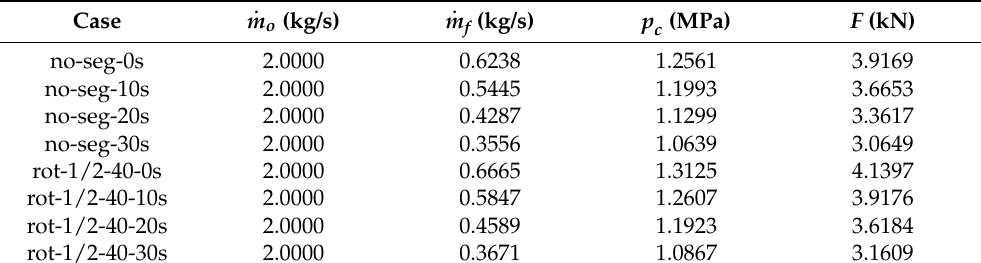
Table 7. Simulation results at different times.